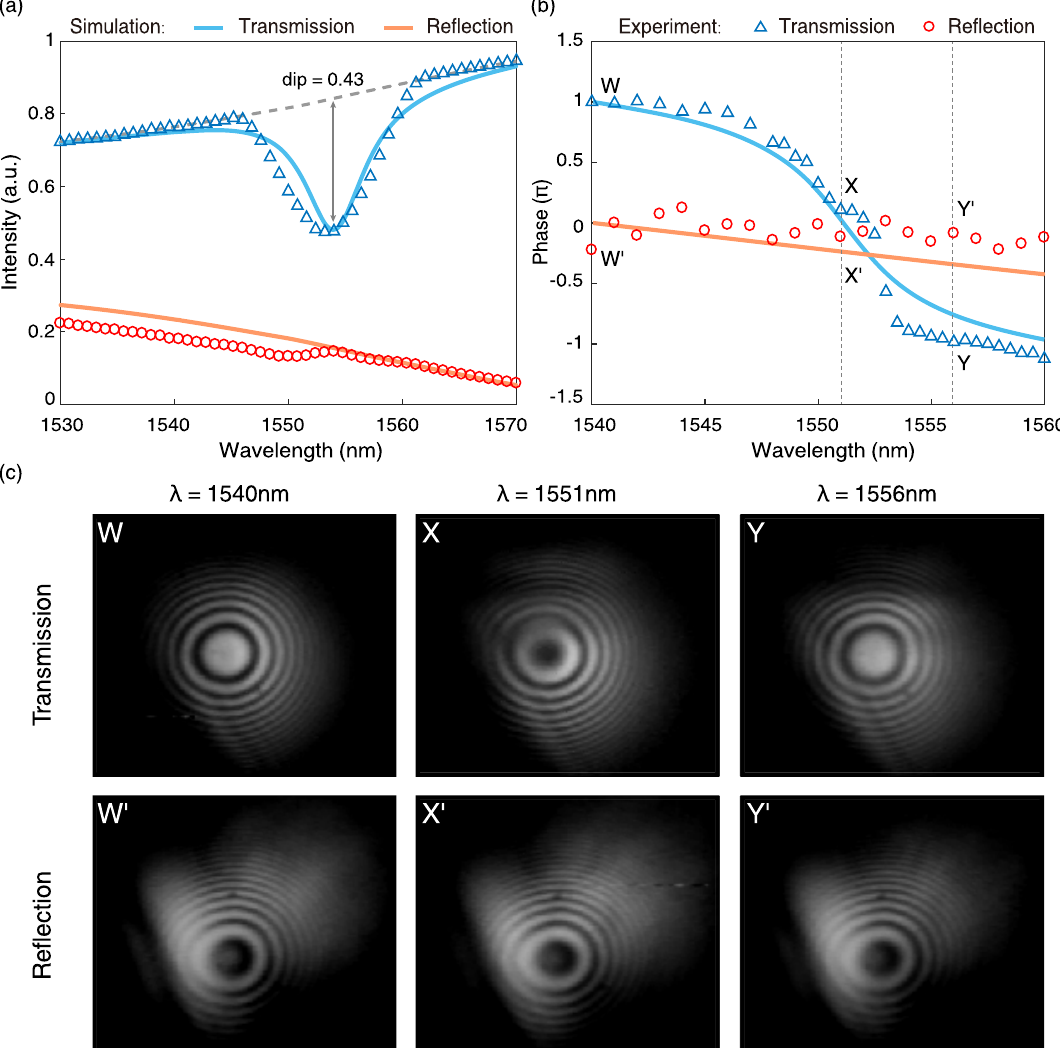
Figure 4: Measured transmittance and reflectance and compassion to numerical simulations. (a) Intensity and (b) phase responses of transmittance and reflectance. The reflectance shows no feature of resonance and is flat in the phase response. Differently, a dip appears upon the transmittance because nonradiative scattering loss, with the dip depth reading as 0.43. The phase shifting of 2 𝜋 is observed from the transmittance. (c) Fringe patterns at 3 specified wavelengths marked in (b). For the transmission (top-panel), a phase shifting of 2 𝜋 is observed from fringe shifting through the point W to Y. While for the reflection (bottom), the pattern are almost steady across the same wavelengths